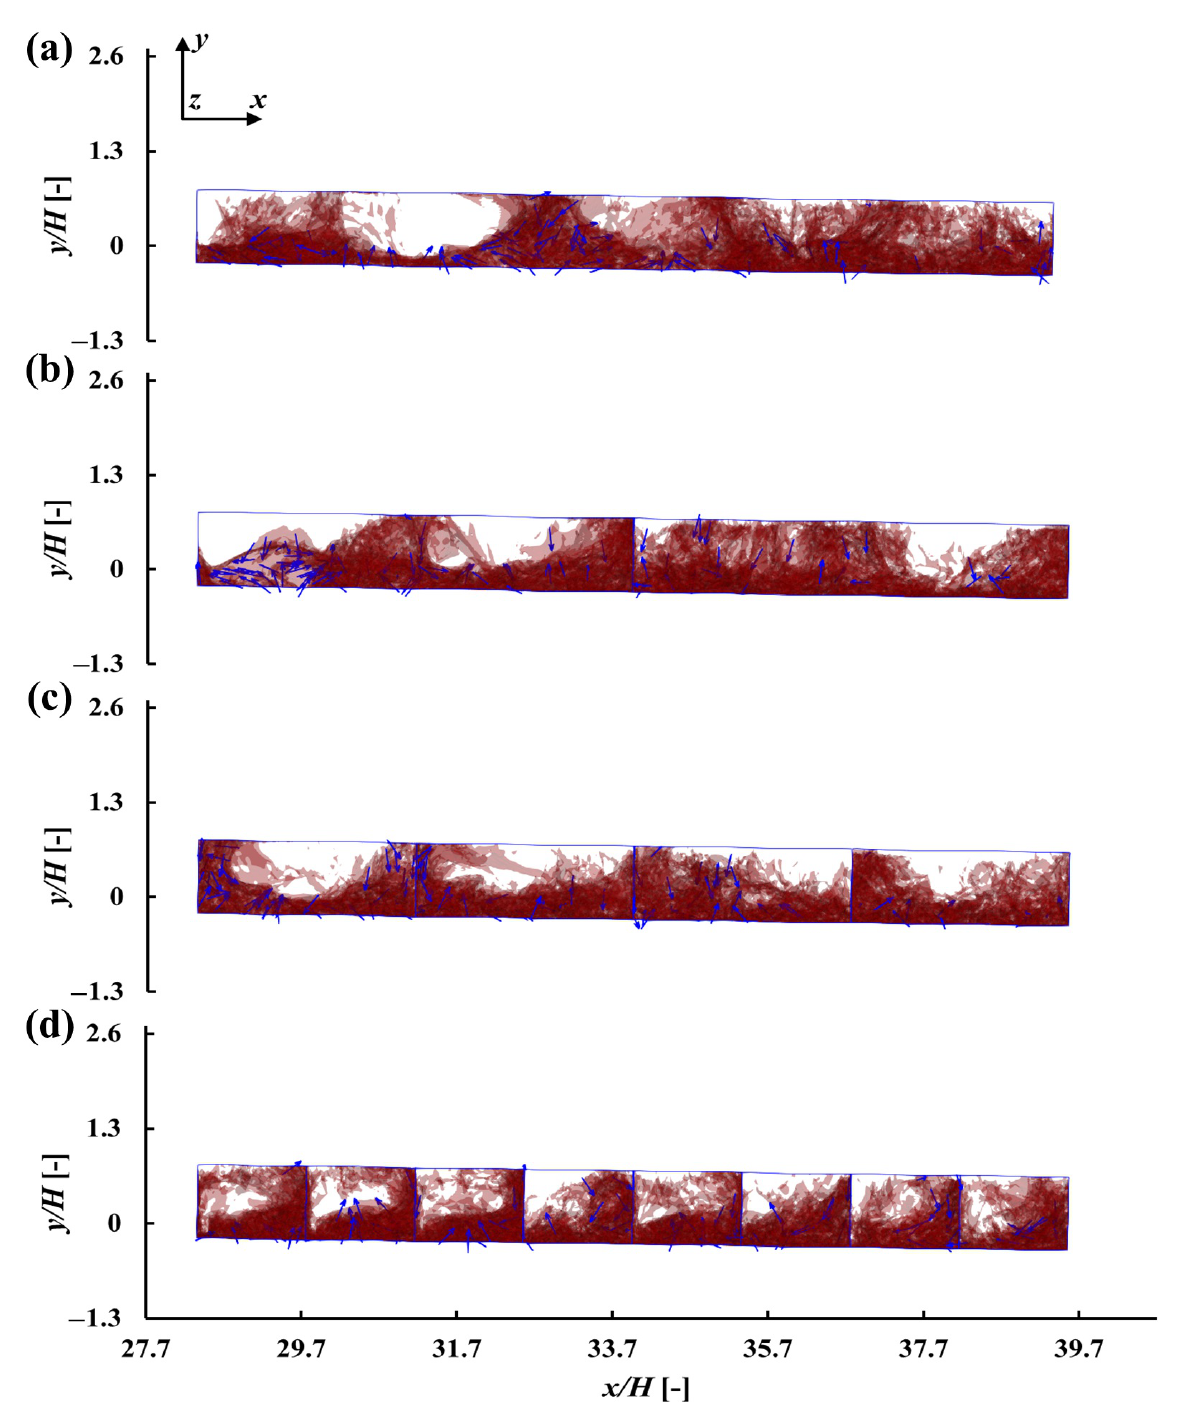
Figure 20. Snapshots for the sloshing tank with D i = 0.5 at t / T = 6.0 for ( a ) N c = 1, ( b ) N c = 2, ( c ) N c = 4 and ( d ) N c = 8. Water phase is shown as transparent red with dark red representing the free surface. Blue arrows show the general direction of motion of the sloshing